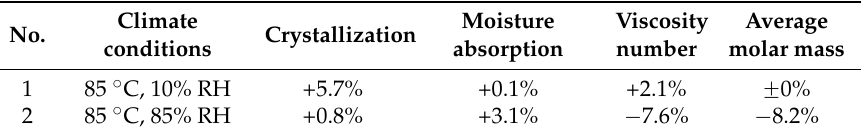
Table 3. Summary of physical and chemical aging processes expressed as post-crystallization, moisture absorption, change of viscosity and molar mass after 1000 h for PA6 GF30.